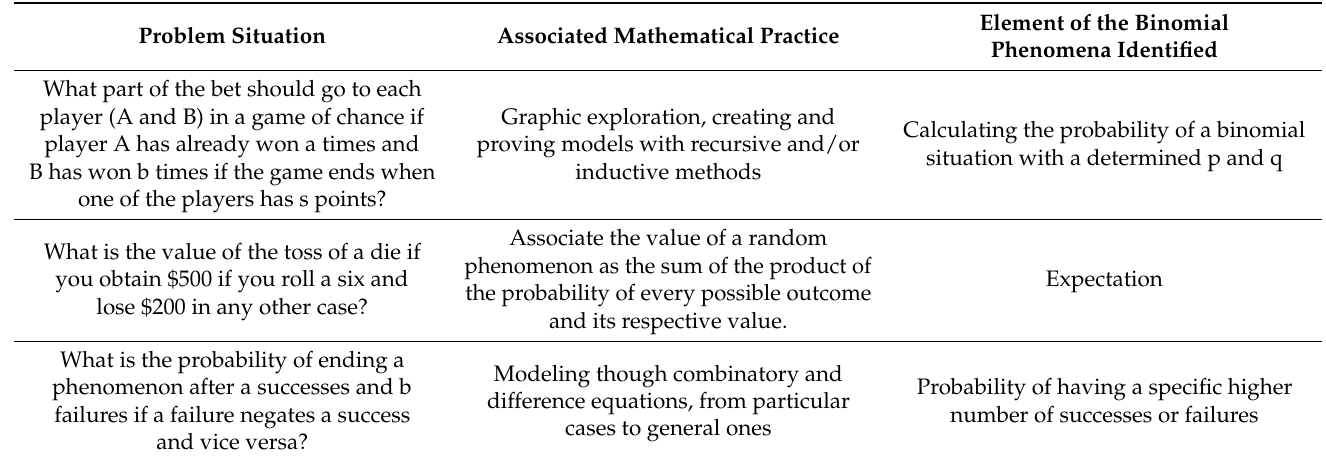
Table 8. How problem situations from historical problem situations (17th century–18th century) could be proposed in the current